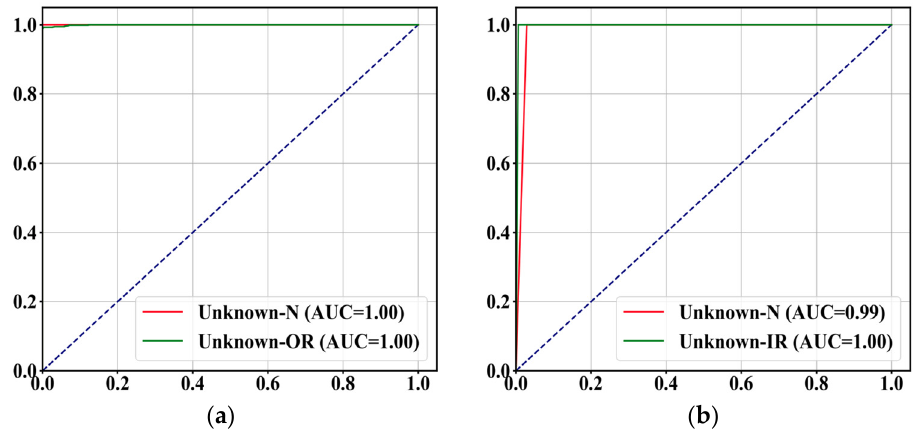
Figure 4. ROC/AUC of feature transferring from CWRU to Ottawa. ( a ) Hidden the labels of inner race faults (IR). ( b ) Hidden the labels of outer race faults (OR).